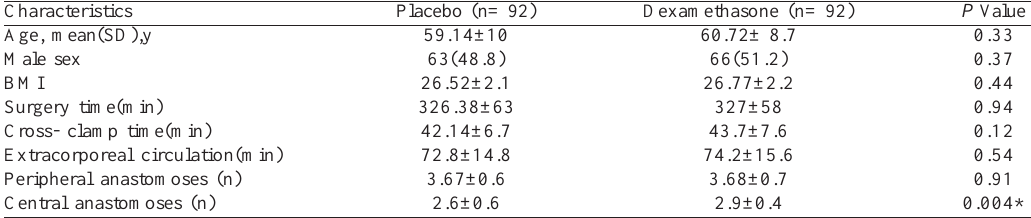
Table 1. Characteristic of the patient groups Characteristics Age, mean(SD),y Male sex BMI Surgery time(min) Cross- clamp time(min) Extracorporeal circulation(min) Peripheral anastomoses (n)